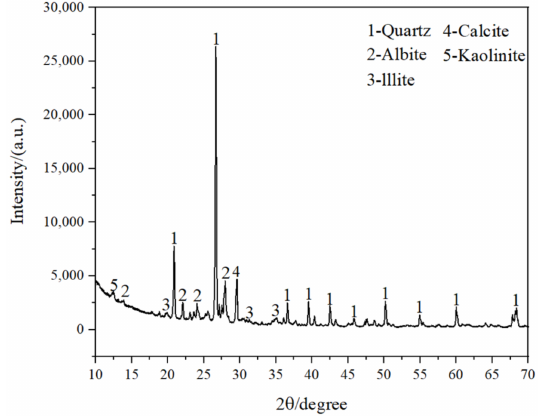
Figure 13. XRD diffraction pattern of Sample